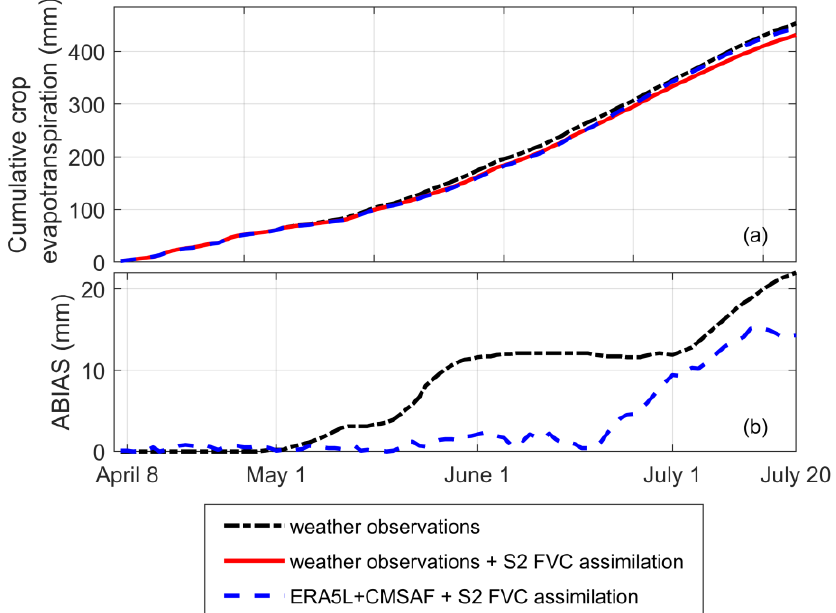
Figure 8. ( a ) Cumulative crop evapotranspiration (mm) for different model inputs, as described in the legend; ( b ) Cumulative ABIAS (mm) of the cumulative crop evapotranspiration computed using two different model inputs (i.e., weather observations and ERA5L + CMSAF + S2 FCV assimilation) versus the cumulative crop evapotranspiration computed using as model input weather observations + S2 FCV assimilation (best estimate).